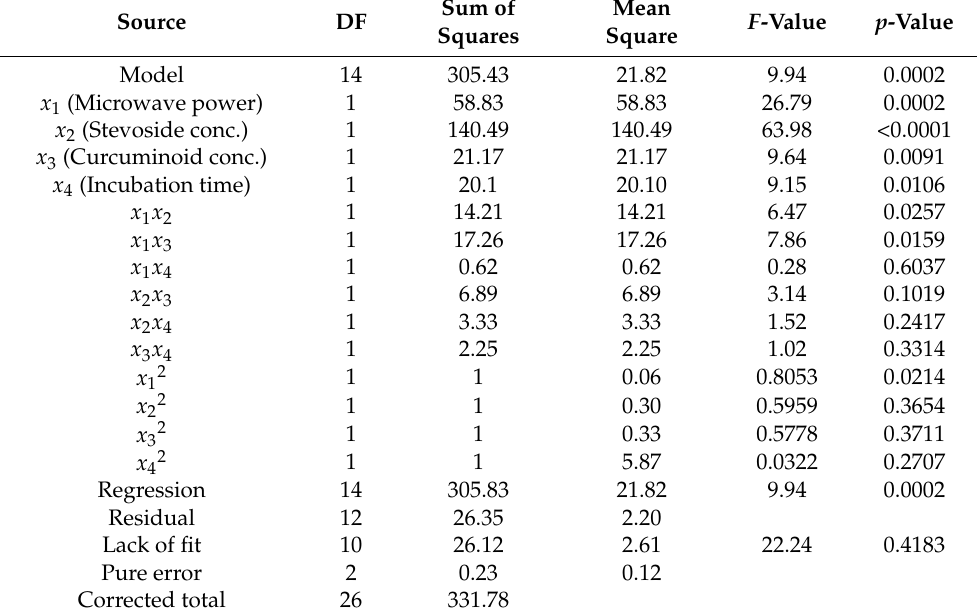
Table 4. Regression coefficients and analysis of variance results.